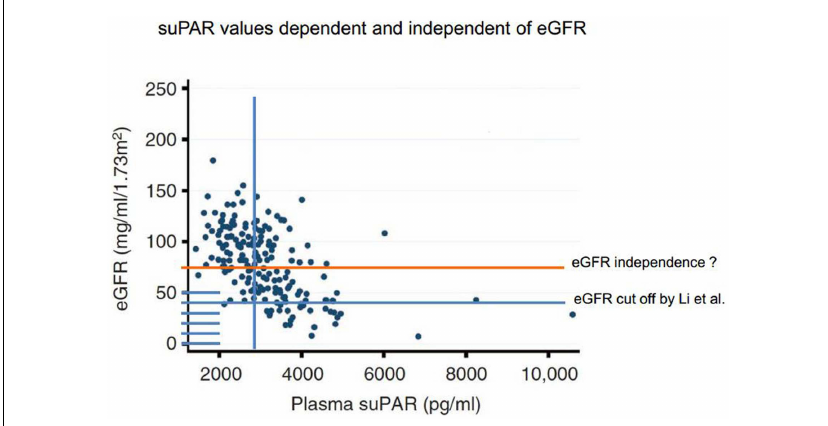
FIGURE 1 | suPAR plasma levels above cut off of 3000pg/ml in patients with eGFR > 40ml/min (blue line) as suggested by Li et al. applied to the patient cohort by Spinale et al .These values are likely not explained by reduced GFR alone. Elevated suPAR level in preserved renal function patients (orange line) is likely not dependent on